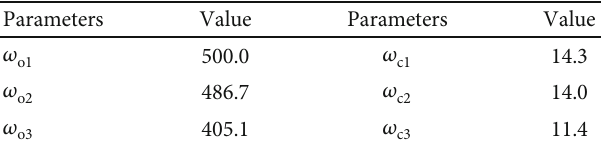
Table 5: Optimal parameters of LADRC. Parameters